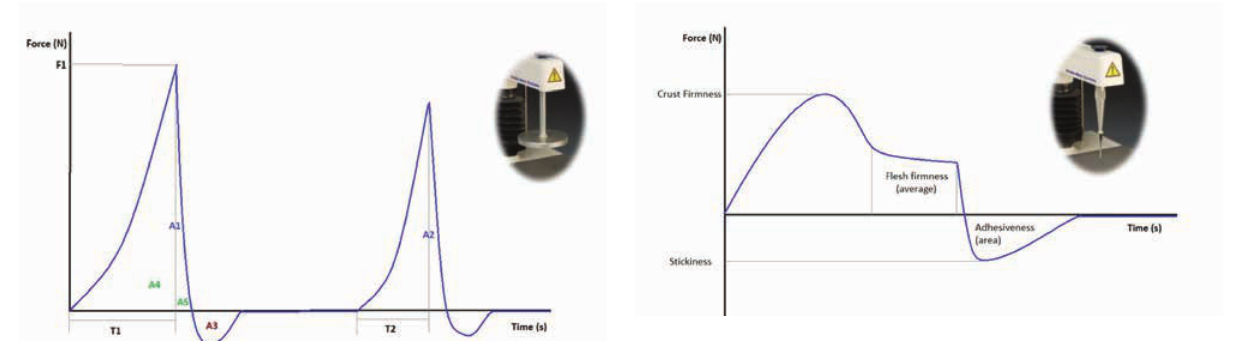
Figure 1: Example of a graph obtained with the compression test using the P/75 probe